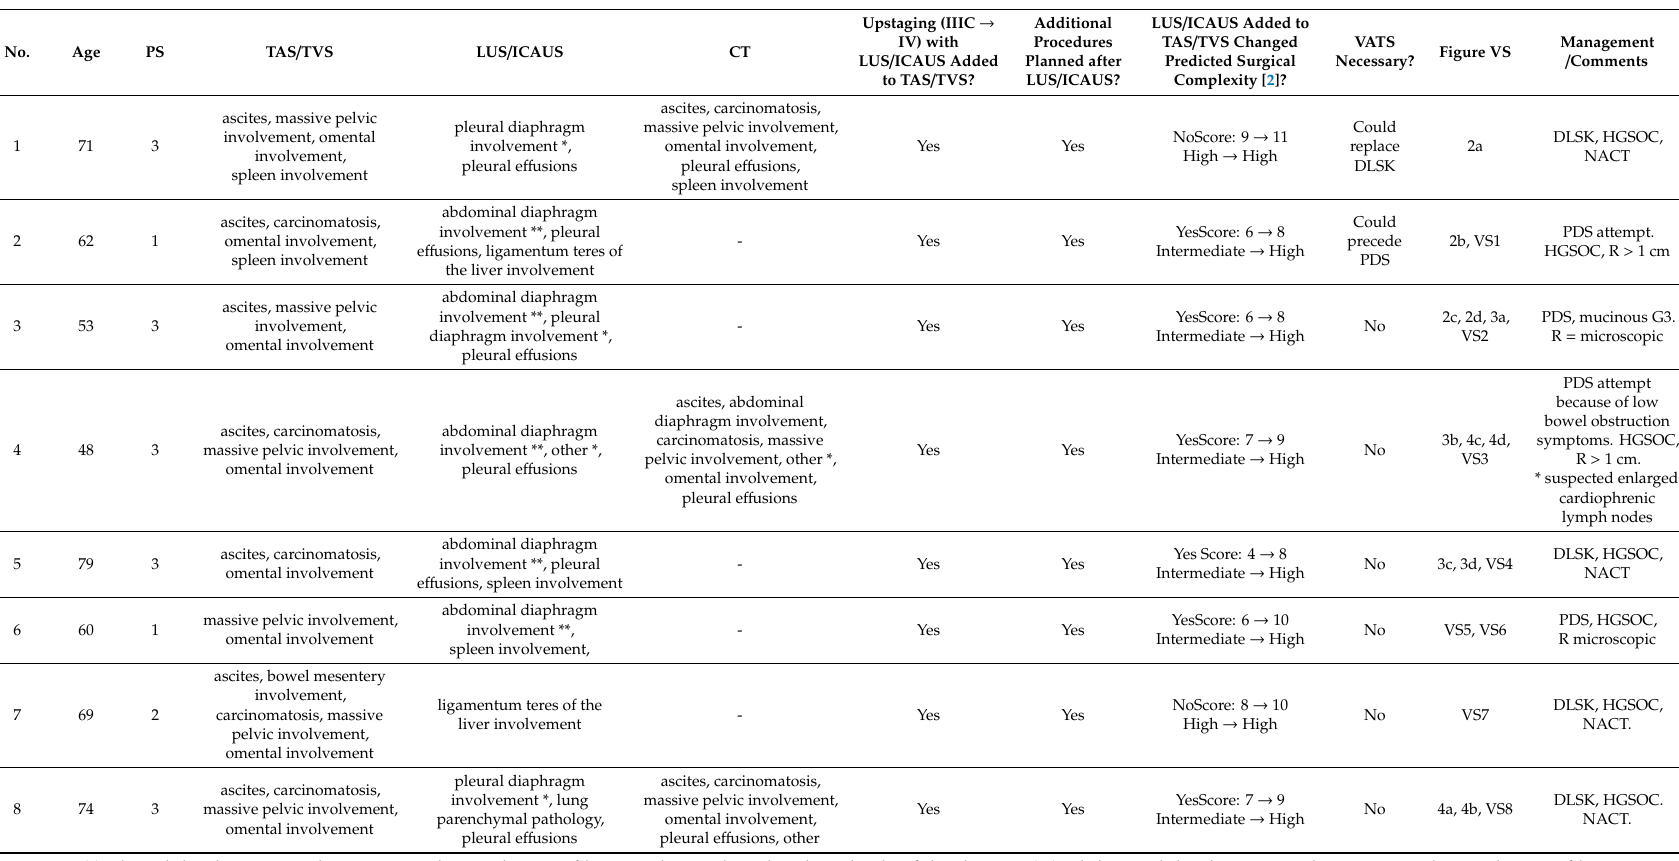
Table A1. Patients’ age, performance status, main ultrasound findings, and impact of lung ultrasound (LUS) and intercostal upper abdomen ultrasound (ICAUS) on staging and surgical